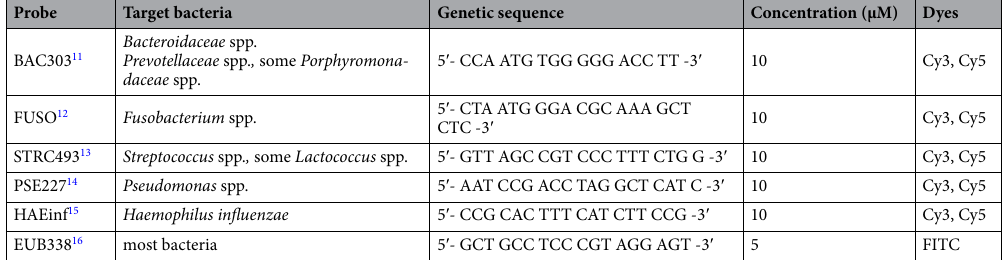
Table 1. Bacterial fluorescence in situ hybridisation (FISH) probes and dilutions. Cy3 carbocyanine dye 3, Cy5 carbocyanine dye 5, FITC fluorescein isothiocyanate.